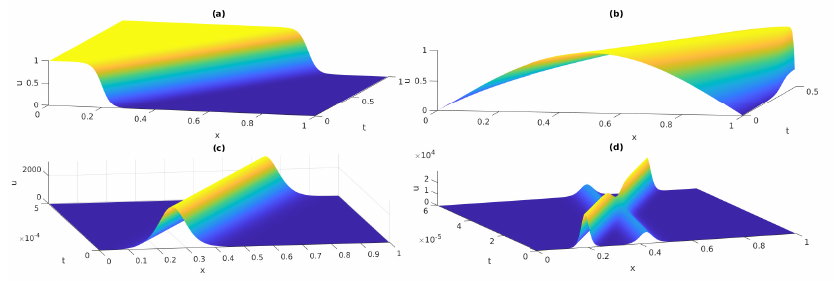
Figure 2. Typical calculated results for HOHWM. (a) Wave equation ( c 1 = 60, J = 7 with boundary conditions (4.5) and initial condition (5.1)); (b) Burgers’ equation ( ν = 1 , J = 7 with boundary conditions (4.8) and initial condition (5.2)); (c) KdV 100 π single soliton solution ( α = 1, c = 1000, x 0 = 1 / 4, J = 7 with boundary conditions (4.11) and initial conditions (5.3)); (d) Interaction of KdV solitons ( α = 1, c B = 10000, x